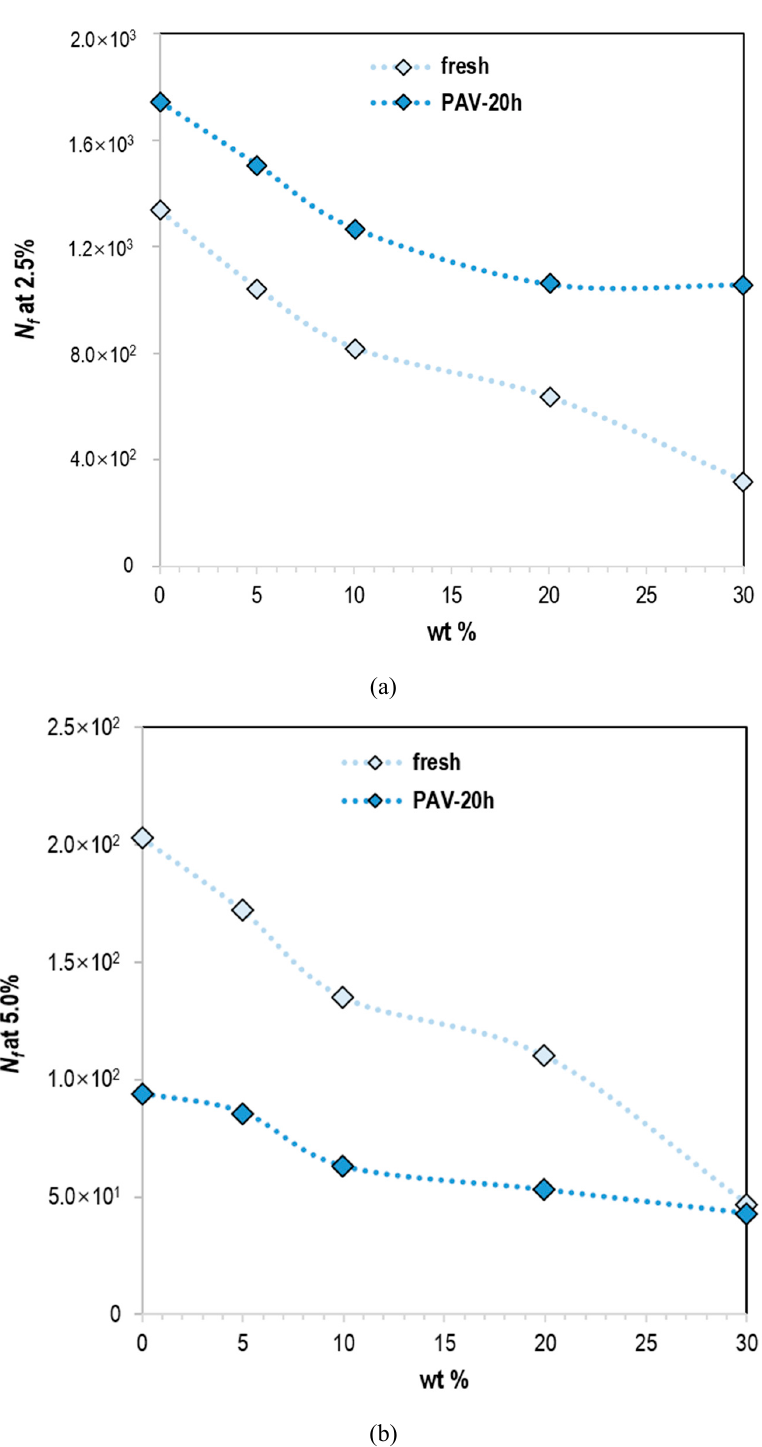
Figure 5. N f at ( a ) 2.5% and ( b ) 5.0% of the applied shear strain of lignin–bitumen systems before and after aging.